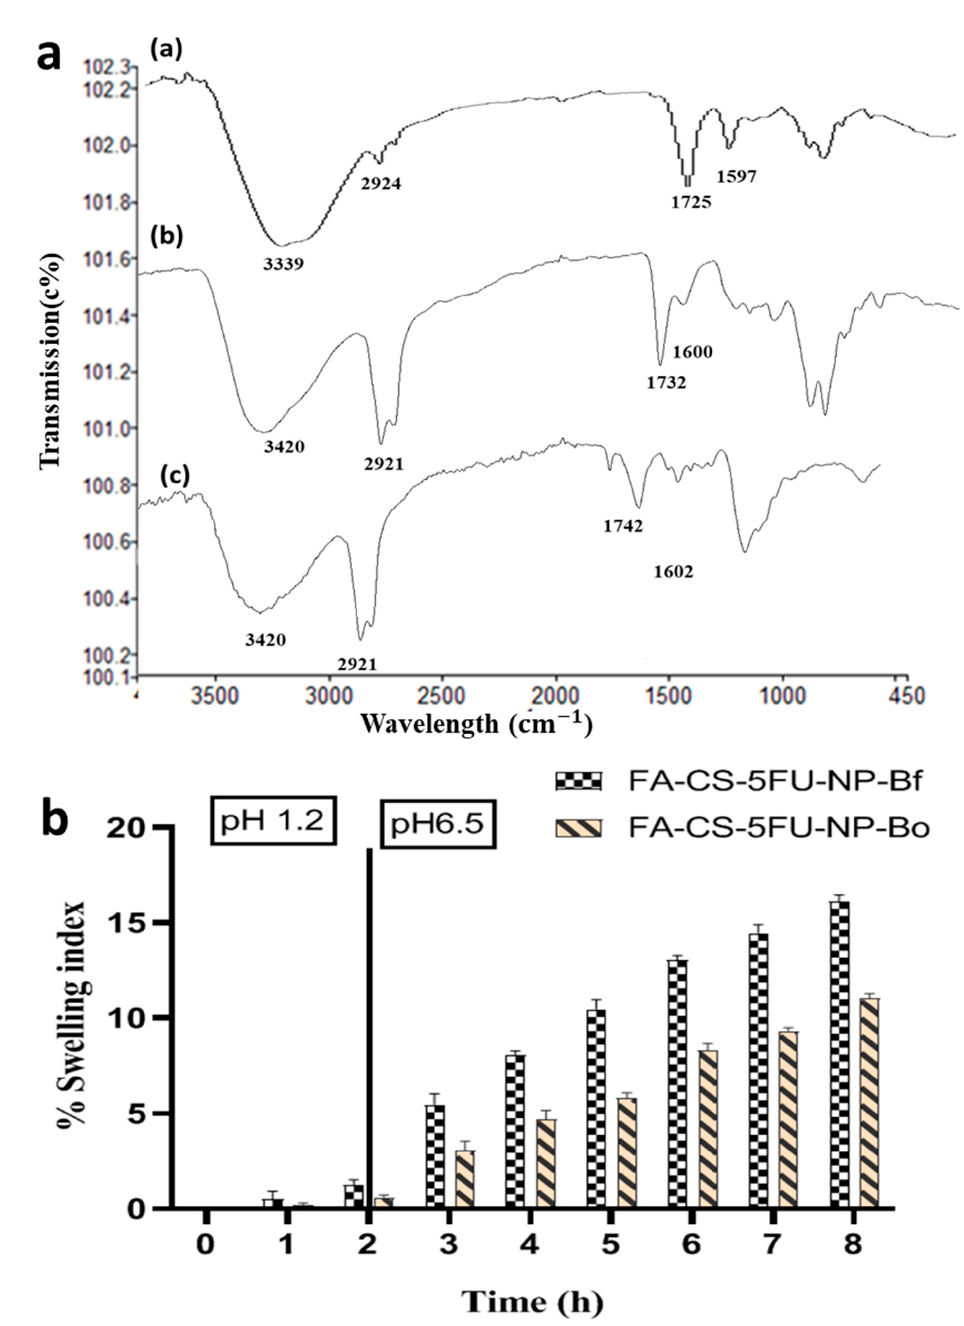
Figure 6. ( a ) FT-IR of swelling study: (a) beads formulation before immersion into fluid medium, (b) beads immersed in a simulated gastric fluid medium, (c) beads immersed into the simulated intestinal fluid medium, and ( b ) swelling behavior of FA-CS-5FU-NP-Bf and FA-CS-5FU-NP-Bo. At acidic pH, percent erosion of FA-CS-5FU-NP-Bf and FA-CS-5FU-NP-Bo beads was found to be 1.3 ± 0.5 and 1.2 ± 0.7%, respectively, which are insignificantly different ( t